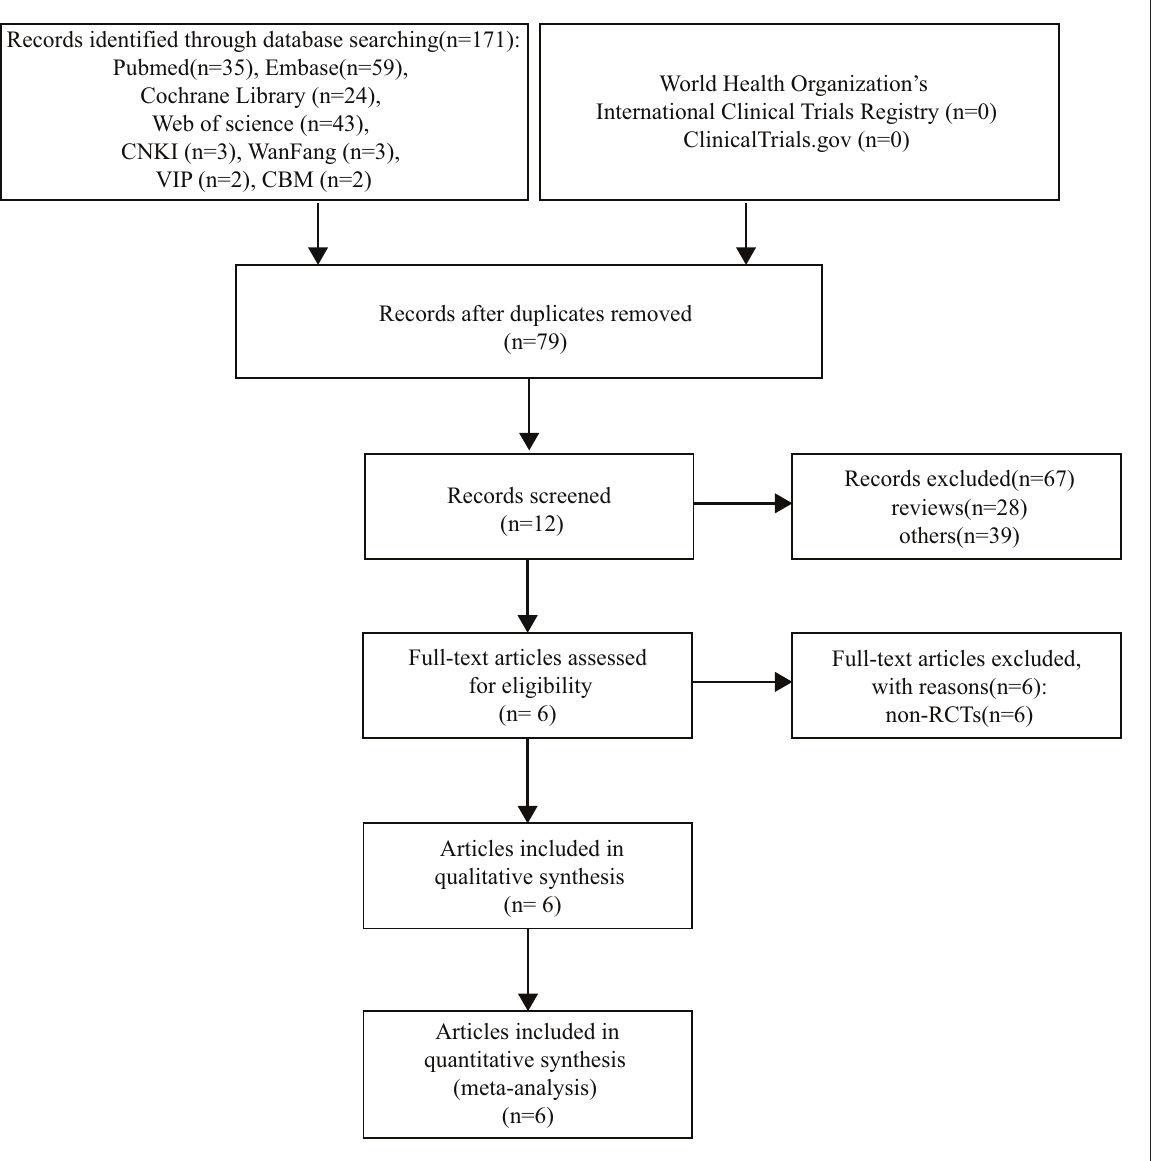
FIGURE 1 | Systematic reviews and meta-analyses (PRISMA) flowchart of study.